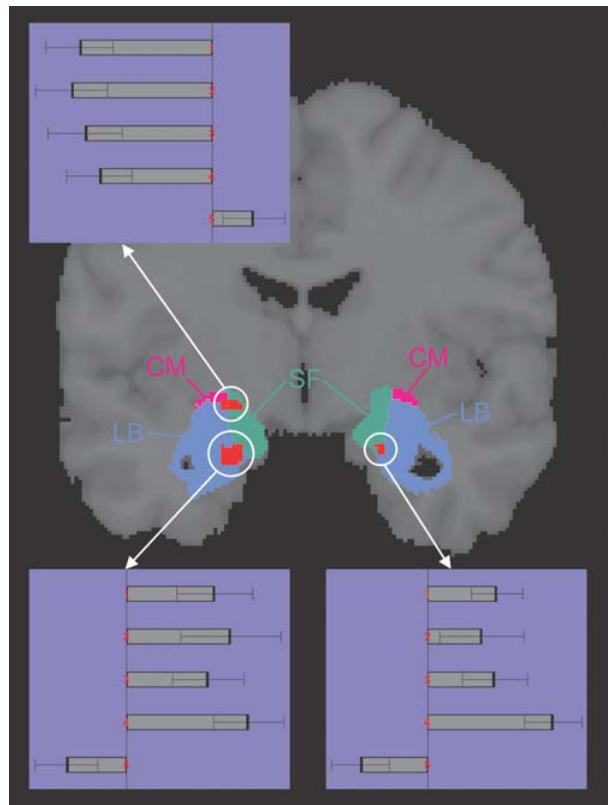
Figure 3. Music-related amygdala responses. The extent of the amygdala subregions LB, SF, and CM defined by maximum-probability maps (MPMs, [28]) are rendered in blue, green, and magenta, respectively, on a coronar section. Regions with significant (p , 0.05, corrected for multiple comparisons in the search volume) music-related responses are shown in red. The BOLD percentage signal change (PSC) of each of the three activation sites in the four music conditions (1: dissonant slow, 2: consonant slow, 3: dissonant fast, 4: consonant fast) is presented as mean and standard error. The fifth PSC value refers to the time period during which subjects evaluated the emotional effect evoked by the preceding musical piece, compared with rest. In the left amygdala, a cluster with positive responses to all music conditions was mainly located in LB and a cluster with negative responses was mainly found in SF and CM (see also Tab. 2). A smaller cluster with consistently positive responses was also found in the right amygdala approximately in the mirror position to the positively responding left